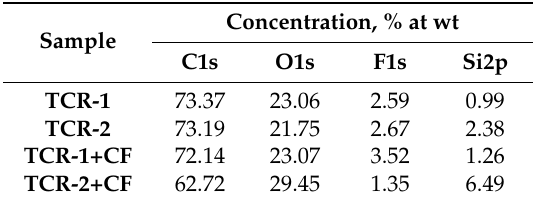
Table 2. Chemical composition of the TCR-1, 2, and TCR + CF nanocomposite sample determined by XPS (atom %).